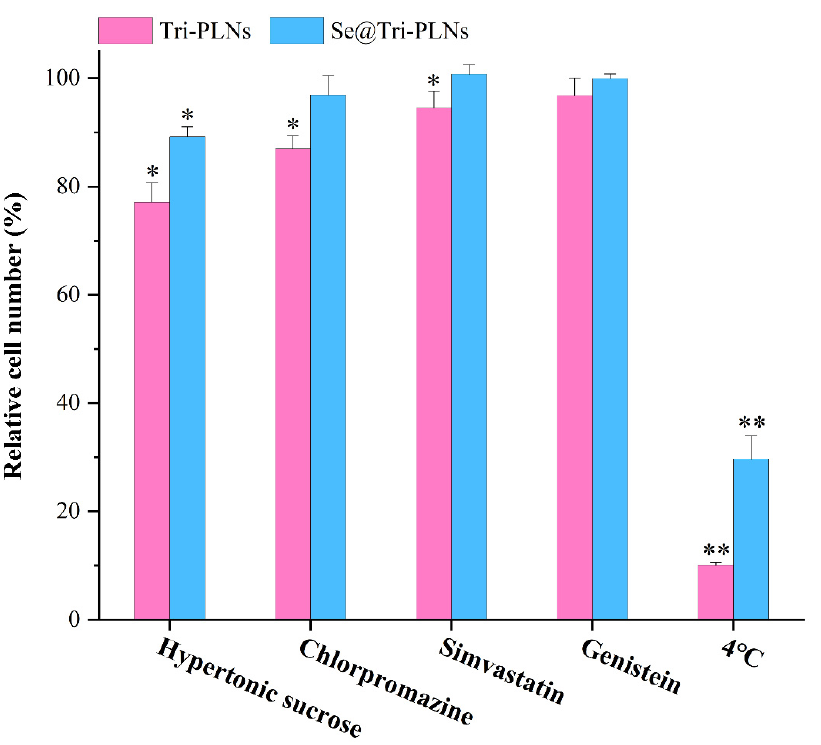
Figure 9. Cellular trafficking pathway of Tri ‐ PLNs and Se@Tri ‐ PLNs interpreted by relative cellular uptake in the presence of various physiological inhibitors or treated under 4 °C ( n = 3). Hypertonic sucrose and chlorpromazine act as nonspecific and specific clathrin ‐ mediated endocytosis inhibitors, respectively; simvastatin and genistein serve as nonspecific and specific caveolin ‐ mediated endocytosis inhibitors, respectively. ANOVA, * p < 0.05, ** p < 0.01, compared with control.